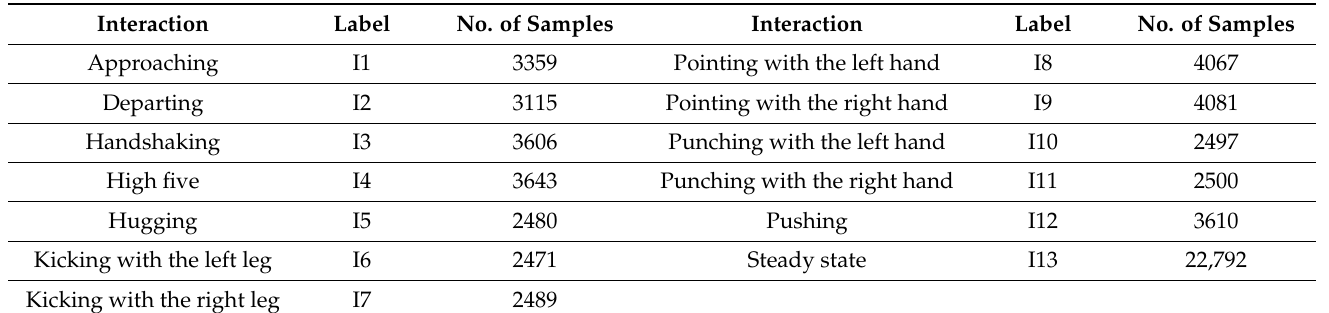
Table 1. Details of the CSI-based HHI